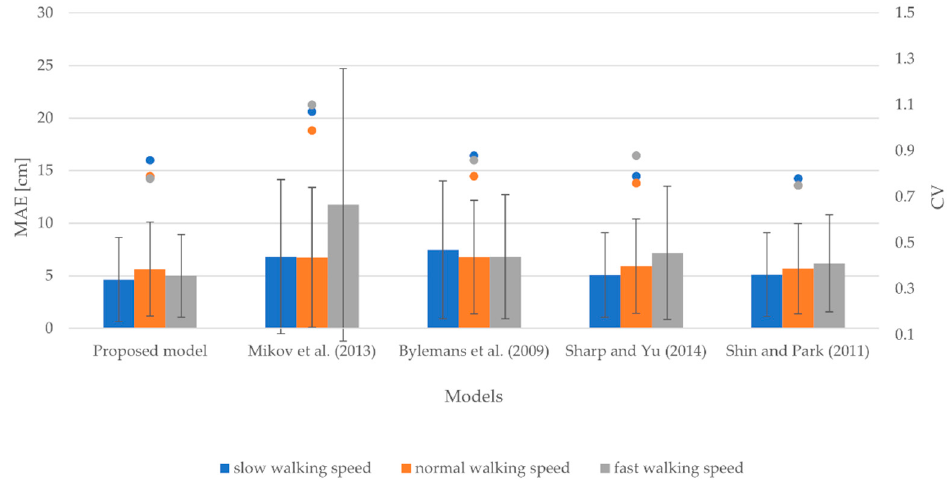
Figure 3. MAEs, SDs, and CVs for slow, normal, and fast walking speeds considering the smartphone attached to the upper arm.